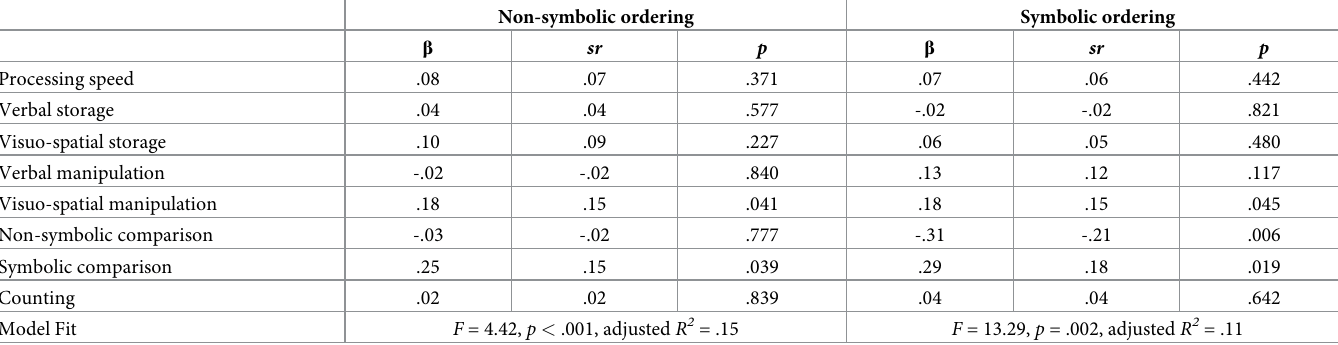
Table 5. Linear regression analyses predicting change in non-symbolic and symbolic ordering from Grade 1–2 by processing speed, working memory storage and manipulation, non-symbolic and symbolic comparison, as well as counting.